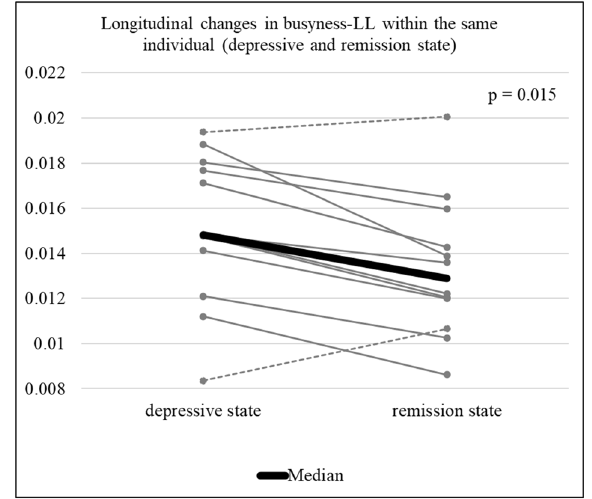
Fig. 3 Longitudinal changes (depressive state [pre-treatment] and remission state [post-treatment]) in busyness-LL within the same individual ( N = 12). LL limbic region in the left